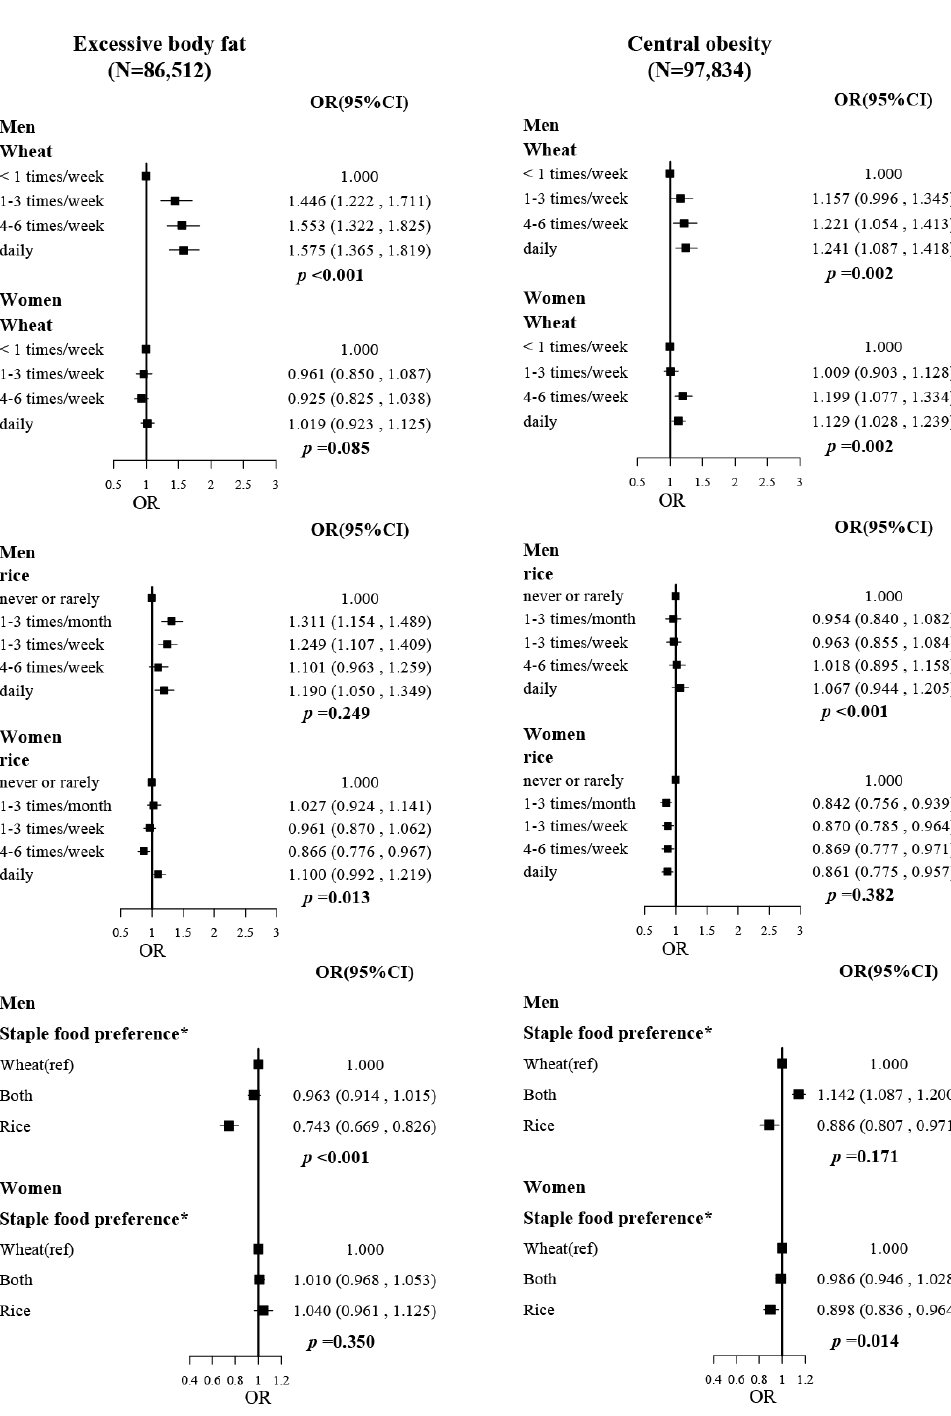
Figure 1. The associations of wheat intake, rice intake, and staple food preference with excessive body fat and central obesity. The “N” on the top of the figure is the total number of participants included in the analysis. Models were fitted based on model 3, with adjustment of age, province, ethnicity, drinking status, smoking status, family income, education level, and physical activity (MET-hr/day). * Staple food preference: rice, consuming rice every day or 4 – 6 times per week, and consuming wheat less than 4 – 6 times per week; wheat, consuming wheat every day or 4 – 6 times per week, and consuming rice less than 4 – 6 times per week; both, the rest of the participants, which means they consumed rice and wheat with similar frequency.